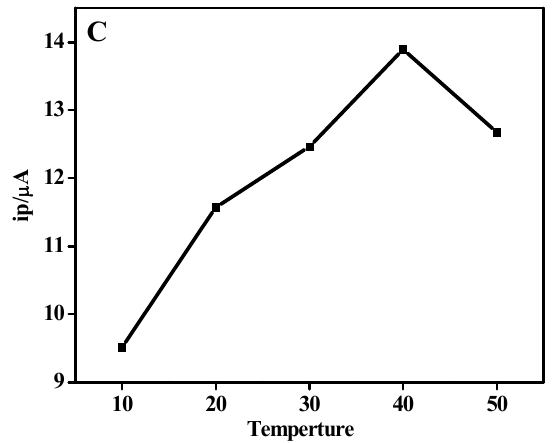
Figure 3. The plots for the relationship of ( A ) the pH value, ( B ) binding time and ( C ) temperature with electrochemical signal in 0.1 M PBS (pH = 7.0).